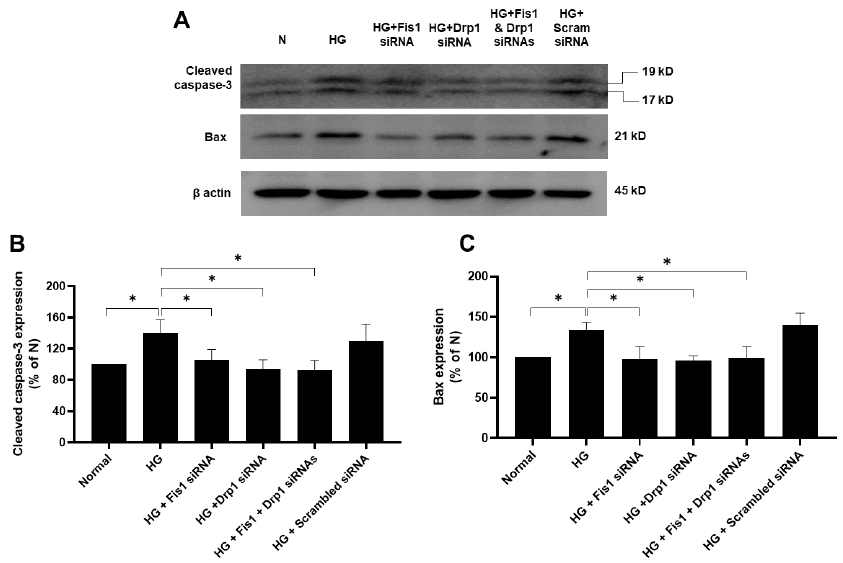
Figure 2. Effect of reducing HG-induced overexpression of fission genes on apoptosis. ( A ) Representative WB image shows cleaved caspase-3 and Bax expression are significantly upregulated in cells grown in HG medium. In contrast, cells grown in HG medium and transfected with Fis1 siRNA, Drp1 siRNA, or both siRNAs exhibit reduced levels of these pro-apoptotic genes. Graphical illustration of cumulative data shows (B) cleaved caspase-3 and (C) Bax levels are downregulated in cells transfected with Fis1 siRNA, Drp1 siRNA, or both siRNAs compared with those of cells grown in HG medium alone. Data are expressed as mean ± SD. * p < 0.05. n = 6.